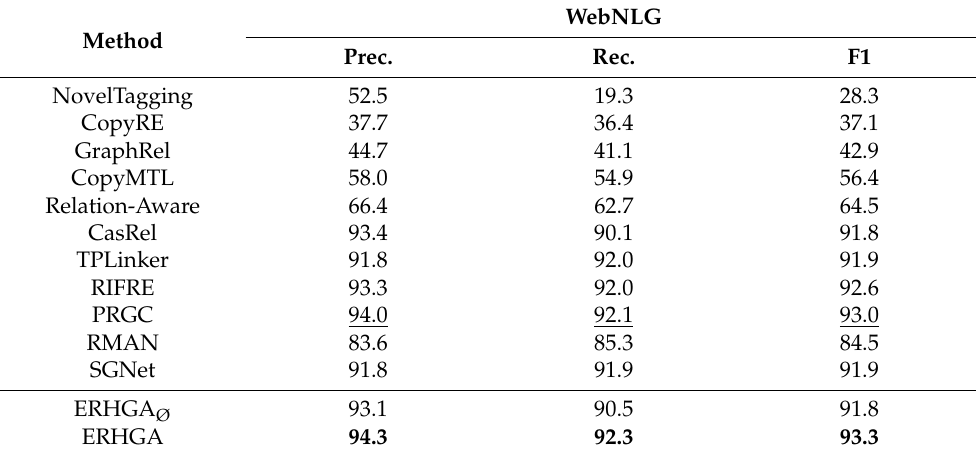
Table 4. Results (%) of the proposed ERHGA method with the prior